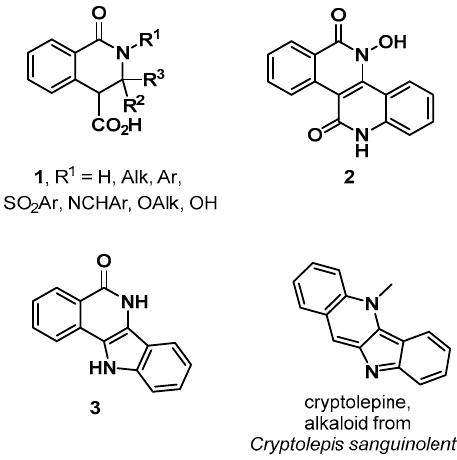
Figure 2. THIQ acids 1 and related scaffolds.